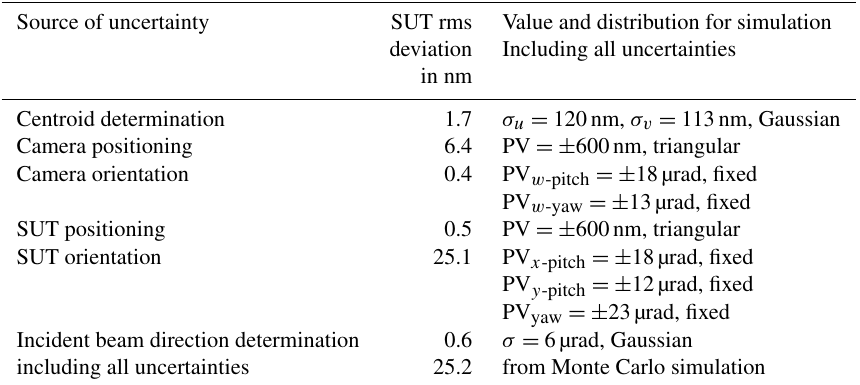
Table 1. All considered uncertainties and their individual and combined influence on the rms surface deviation from the simulation of the measurement of the polynomial freeform described in Sect. 3.1.